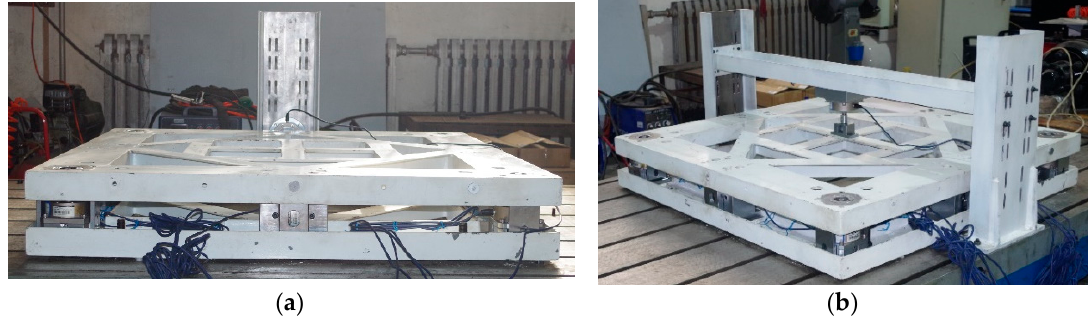
Figure 10. Calibration experiment setup for force loading of the proposed six-dimensional sensor in ( a ) the X-direction and ( b ) the Z-direction.